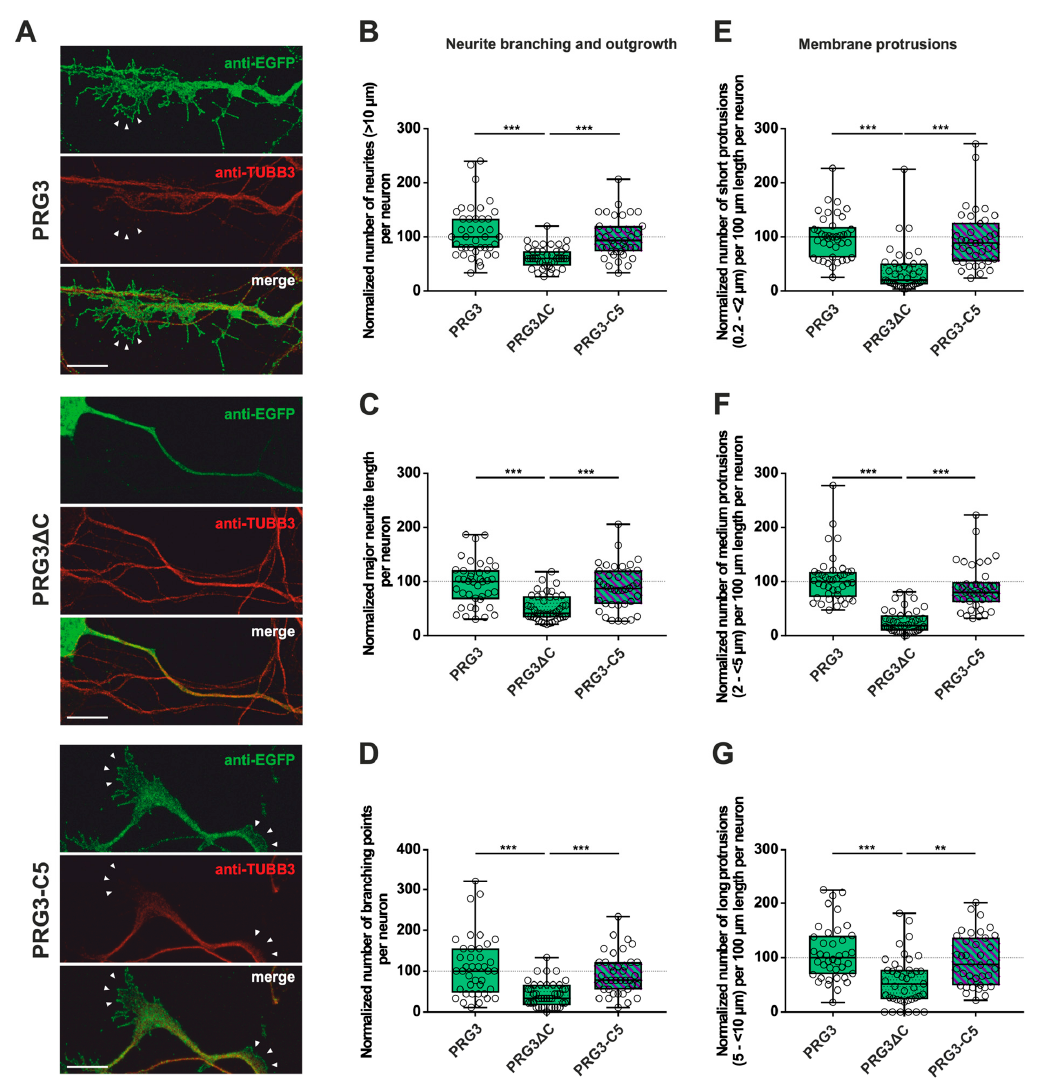
Figure 3. The PRG3 C-terminal domain is an important player in the early development of hippocampal neurons. Subcellular distribution of PRG3-, PRG3 ∆ C- and PRG3-C5-encoding fusion proteins in immature primary hippocampal neurons in culture. Hippocampal neurons in culture were transfected at DIV1 with ( A ) either PRG3- (upper panel), PRG3 ∆ C- (middle panel), or PRG3-C5-encoding plasmids (lower panel), and analyzed at DIV2. Confocal stacks of representative neurons with immunocytochemistry of the respective fusion proteins and stained for GFP to visualize the morphology of the cell or tubulin are shown. Arrowheads denote membrane localization. The scale bar represents 10 µm. Boxplots showing the quantification of ( B ) the total number of neurites (*** p ≤ 0.0001); ( C ) the major neurite length (*** p ≤ 0.0001); ( D ) the number of branching points (*** p ≤ 0.0001) in PRG3-, PRG3 ∆ C- and PRG3-C5-overexpressing neurons. Quantification of membrane protrusions in subgroups based on the length of the ( E ) group of short protrusions (0.2–<2 µm), ( F ) medium protrusions (2–<5 µm) and ( G ) long protrusions (5–<10 µm) (*** p ≤ 0.0001, ** p ≤ 0.01) in the same neurons (PRG3 n = 40, PRG3 ∆ C n = 41, PRG3-C5 n = 38 neurons). All data are presented as median and IQR. Boxes range from 1st to 3rd quartile. Horizontal lines represent medians. Whiskers represent minimum and maximum. Dots represent the values of individual neurons. Statistical analysis was performed using the Kruskal–Wallis test. A level of confidence of p ≤ 0.05 was adopted ** p ≤ 0.01, *** p ≤ 0.001). PRG3 was always set to 100 and the ratios of changes of the different analyses of morphology are shown ( B – G